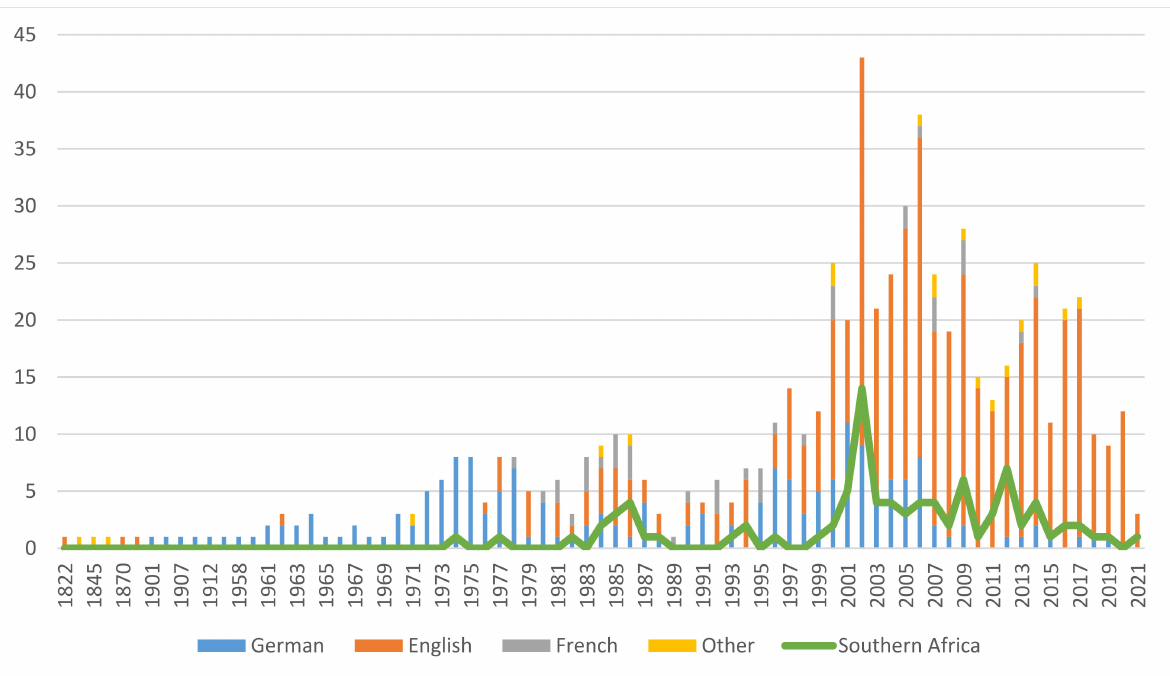
Figure 1. Publications on Harpagophytum spp., 1822–2021 (colors indicate publication language/origin of